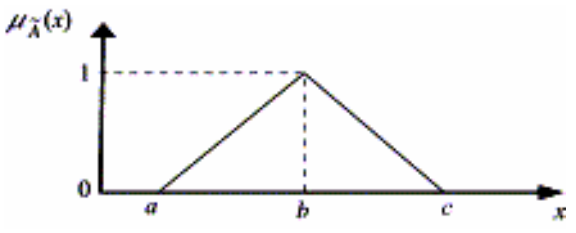
Fig 1. A triangular fuzzy number